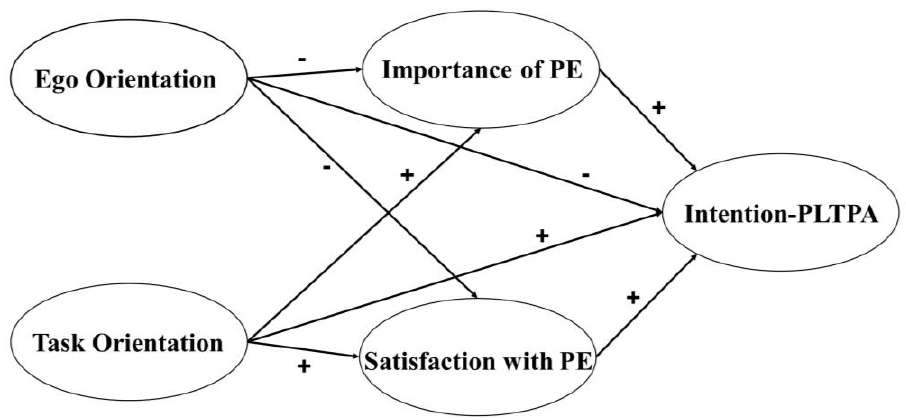
Figure 1. Hypothesized model. Note: dashed lines represent non-significant relationships. Note: PE = Physical Education; Intention-PLTPA = intention to partake in leisure time physical activity.